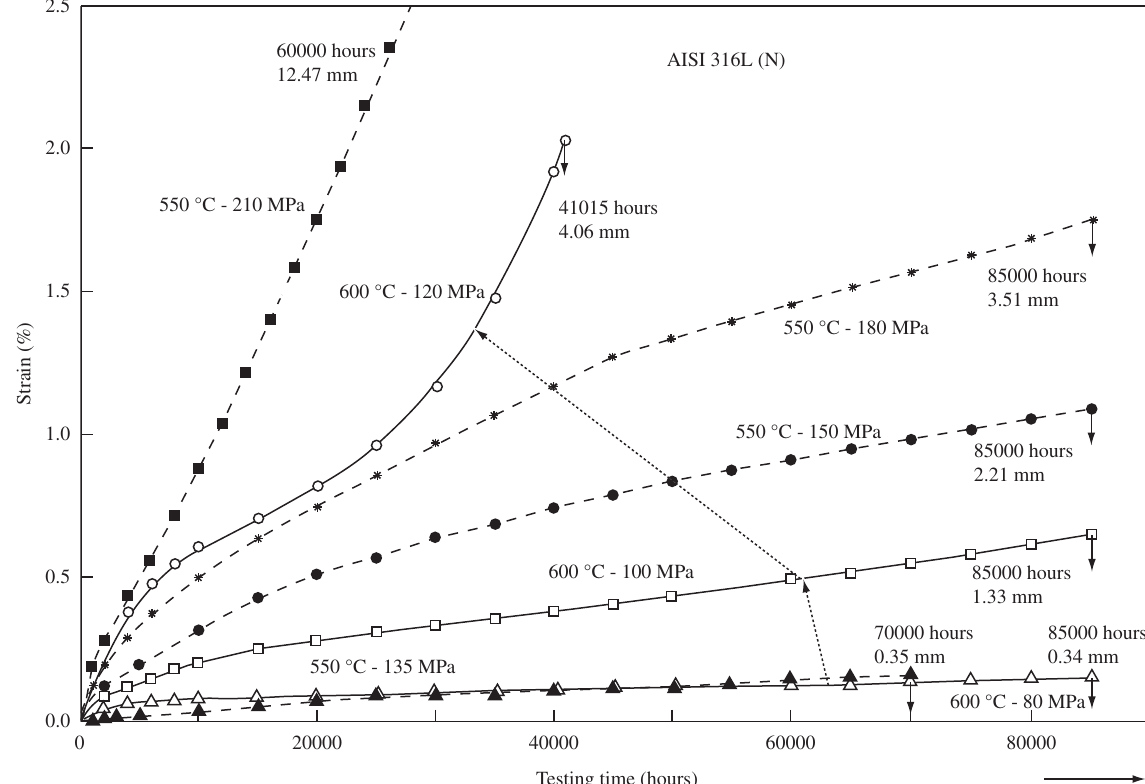
Figure 5. Creep curves for the AISI 316L(N) austenitic stainless steel 44,45 .